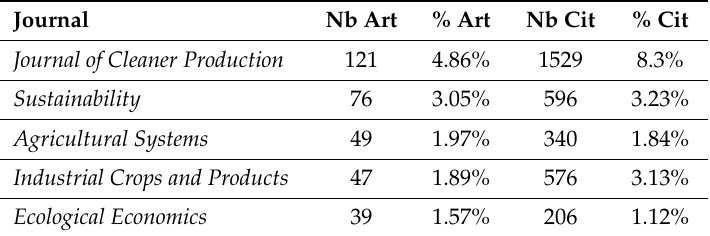
Table 3. The journals with the highest number and share of articles and citations ( n = 2489).